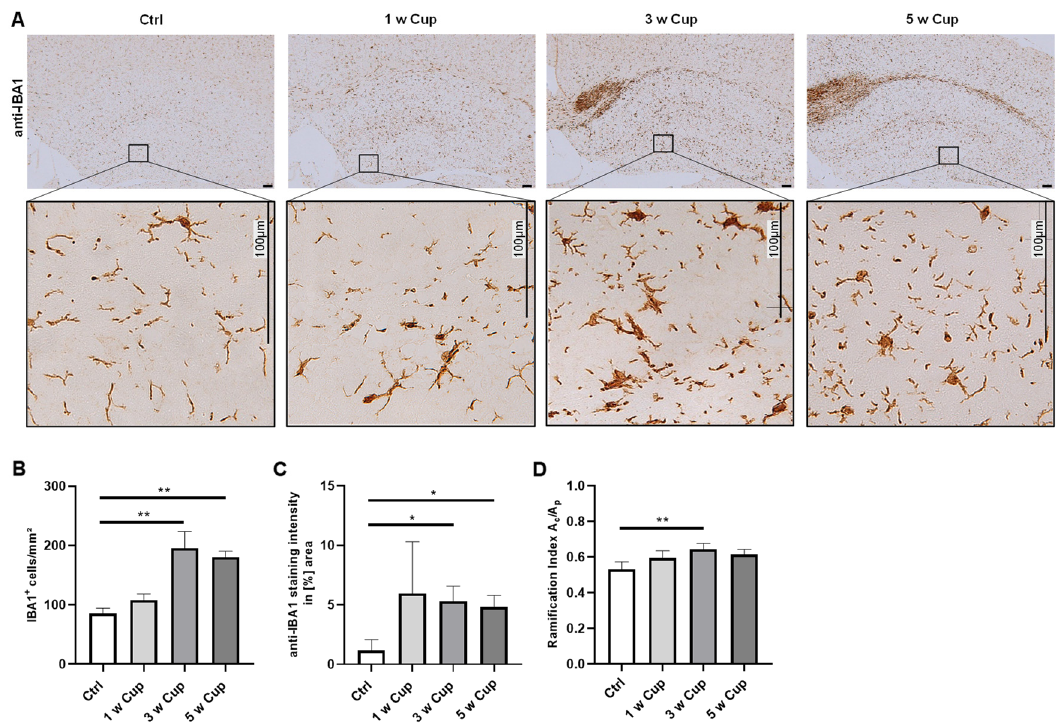
Figure 4. Microglia activation in the hippocampus of cuprizone-intoxicated mice (n = 5 per group). ( A ) Representative anti-IBA1 staining of control (Ctrl), 1, 3, and 5 w Cup mice. Insets depict repre- sentative IBA1 + cells in the hippocampus. ( B ) IBA1 + cell numbers were manually counted by two independent evaluators (MW and YB) blinded to the treatment groups. IBA1 + cell densities were significantly increased after 3 and 5 w of cuprizone intoxication. ( C ) Densitometrically measured IBA1 + staining intensities demonstrated a significant increase during the course of cuprizone intox- ication. ( D ) The ramification indices of microglia in the hippocampus were increased after 3 w of cuprizone intoxication. Kruskal–Wallis test followed by Dunn’s multiple comparisons test were used to test for significant differences between Ctrl and all cuprizone-intoxicated groups. A c : cell area. A p : projection area. *p ≤ 0.05, **p ≤ 0.01.